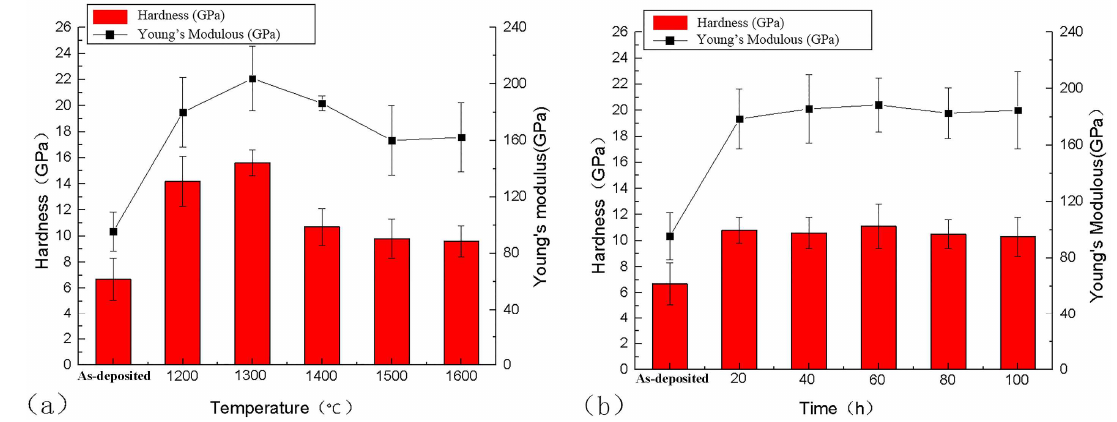
Figure 10 Figure 10. Hardness and Young’s modulus of the as-sprayed coating and the heat-treated coatings: ( a ) samples after heat-treatment for 24 h at di ff erent temperatures; ( b ) samples after heat-treatment at 1550 ◦ C for di ff erent